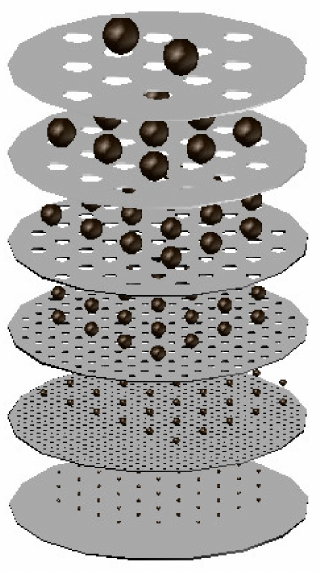
Figure 4. A sketch of a sieve analysis.